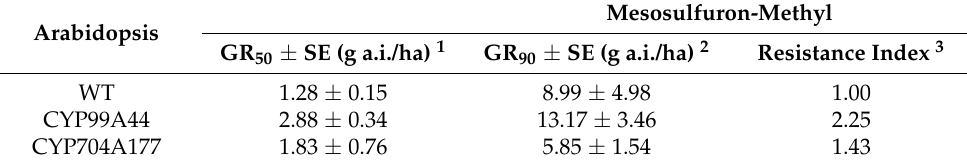
Table 2. Herbicide sensitivity of wild type and transgenic Arabidopsis expressing CYP99A44 and CYP704A177 to mesosulfuron-methyl.